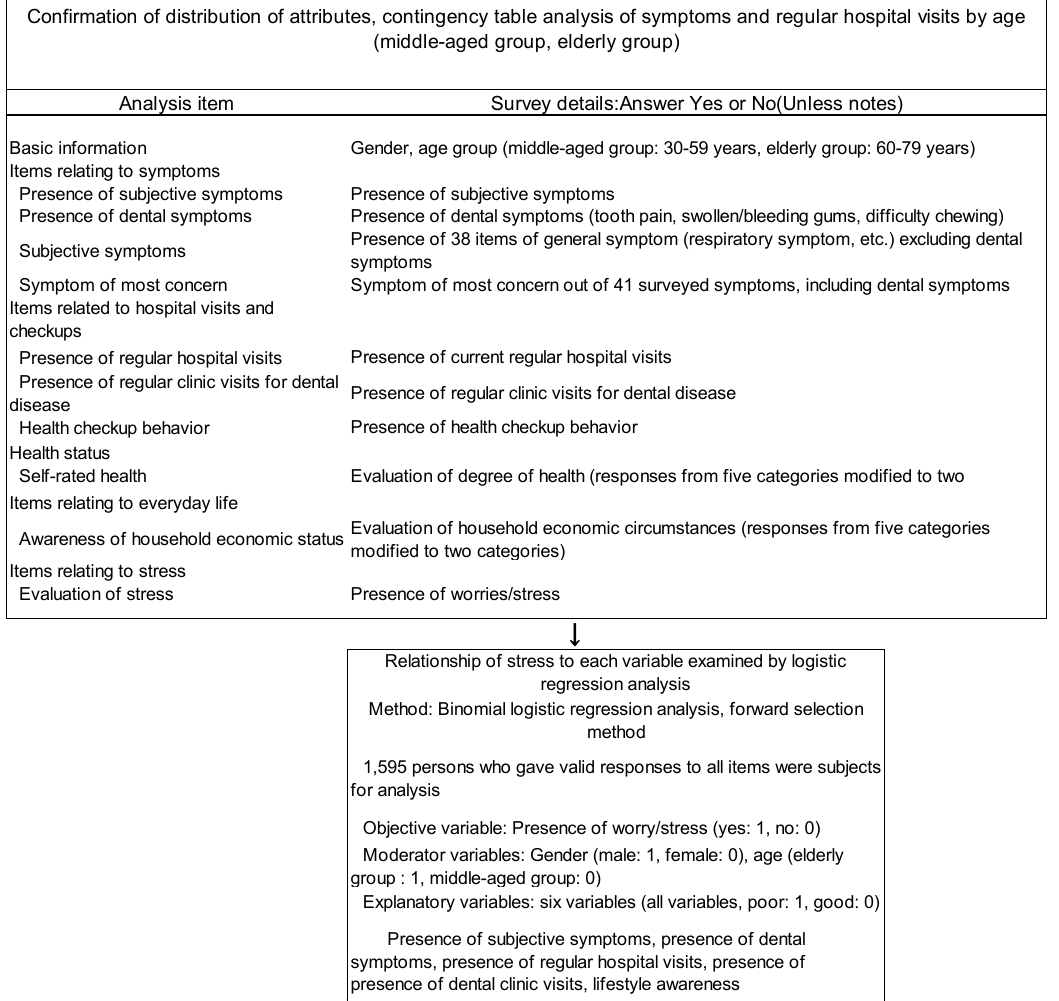
Figure 1. Outline of the data analysis in the study.